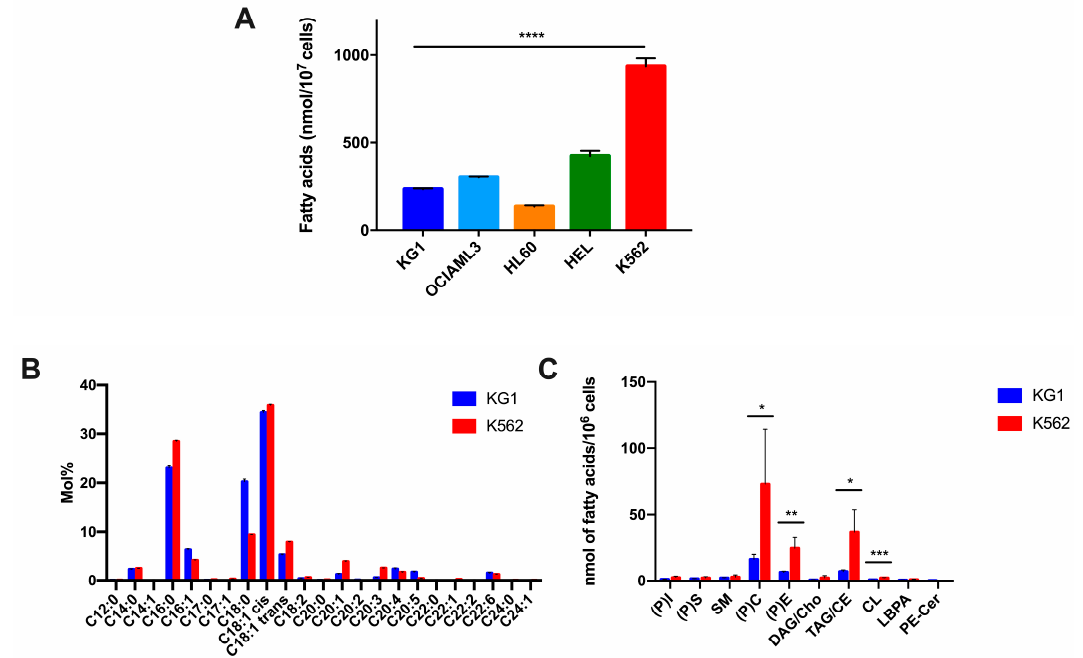
Figure 1. Characterization of the lipid profiles of the leukemic cell lines at basal state. ( A ) Total fatty acid quantification in the five leukemic cell lines. ( B ) Composition of total fatty acids in KG1 and K562 cells. ( C ) Lipid species quantification in KG1 and K562 cells. * p < 0.05, ** p < 0.01, *** p <